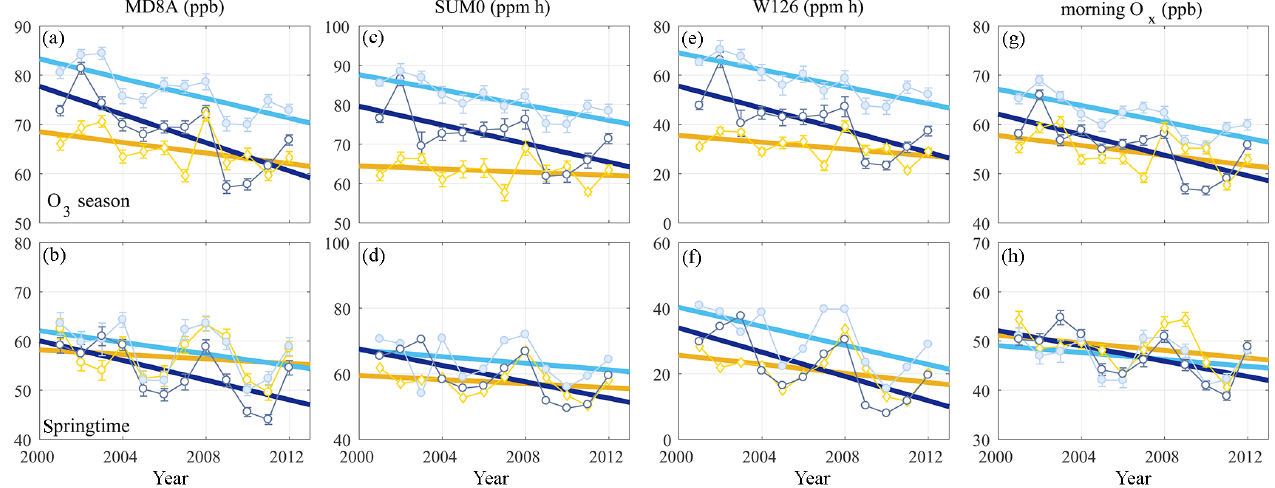
Figure 6. O 3 trends in Visalia (orange diamonds), SEQ1 (cyan filled circles), and SEQ2 (dark blue open circles) computed using MD8A (a–b) , SUM0 (c–d) , W126 (e–f) , and morning O x (g–h) metrics during O 3 season (a, c, e, g) and springtime (b, d, f, h) . Both MD8A and morning O x are computed as seasonal averages. Error bars in (a) – (b) and (g) – (h) are standard errors of the mean. Error bars in (c) and (e) are standard errors of the mean of the three O 3 season 3-month summations. Table 2. O 3 changes in Visalia, SEQ1, and SEQ2 over 2001–2012 according to MD8A, SUM0, W126, and morning O x metrics based on a linear fit of annual mean data (shown in Fig. 6) in the springtime and O 3 season. Each left column is the percent change with respect to fit value in 2001 at SEQ1 during O 3 season for comparison, which is the highest O 3 observed for each metric. Each right column is the fit slope with slope errors in O 3 abundance units per year. Font style is based on the TOAR categorization for trend significance (Lefohn et al., 2018), with p values calculated using the Mann–Kendell nonparametric test: bold italics, 0–0.05, statistically significant trend; bold, 0.05–0.10, indicative of a trend; italics, 0.10–0.34, weak indication of change; and normal font, 0.34–1, weak or no change. O 3 metric MD8A SUM0 W126 Morning O